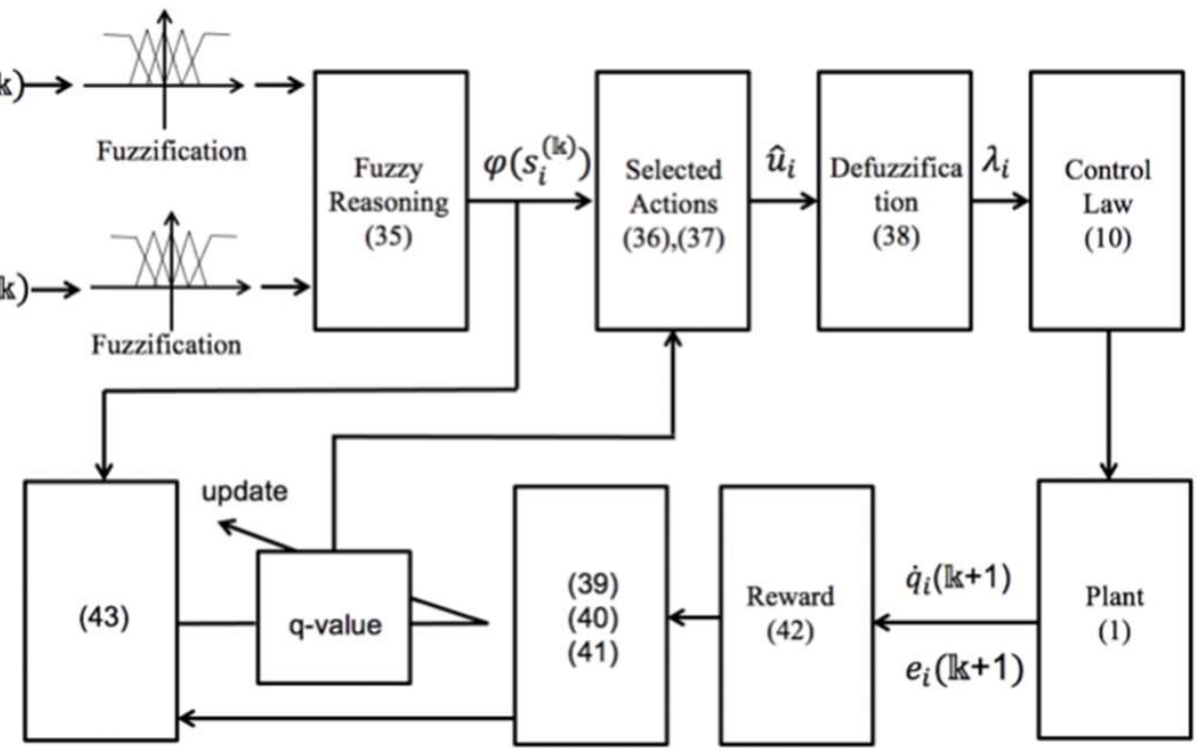
Figure 2. Membership function of fuzzy input of the 𝑖 (cid:3047)(cid:3035) subsystem. . (cid:3036)